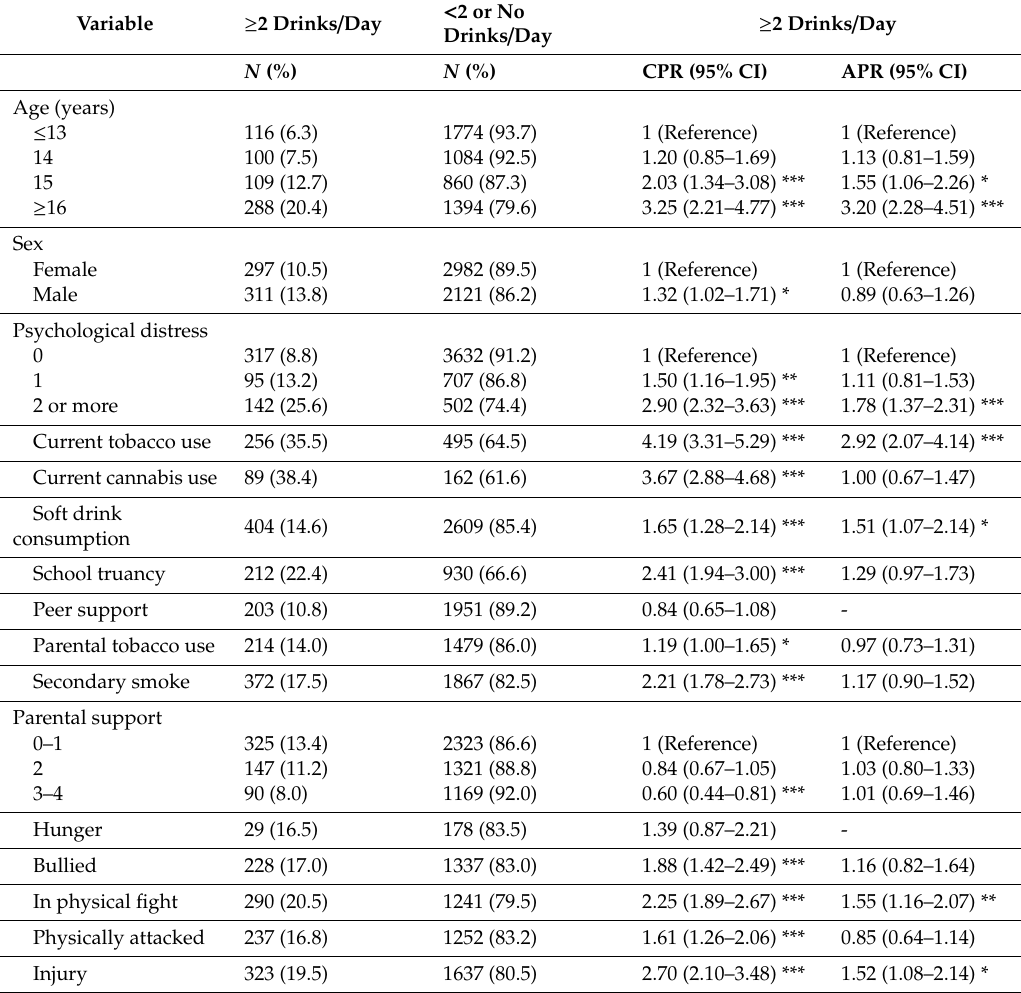
Table 5. Associations with ≥ 2 drinks /